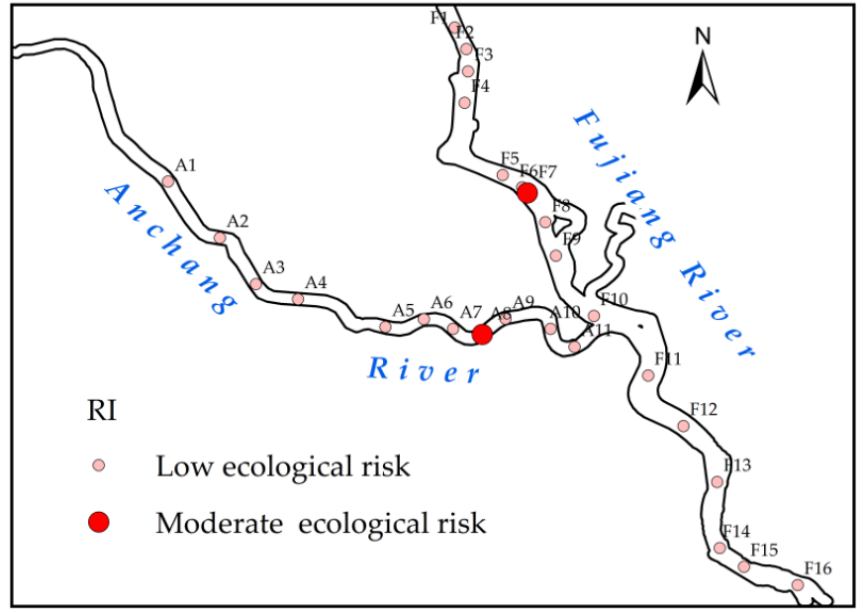
Figure 6. RI degree for HMs in the Mianyang section of the Fujiang River.